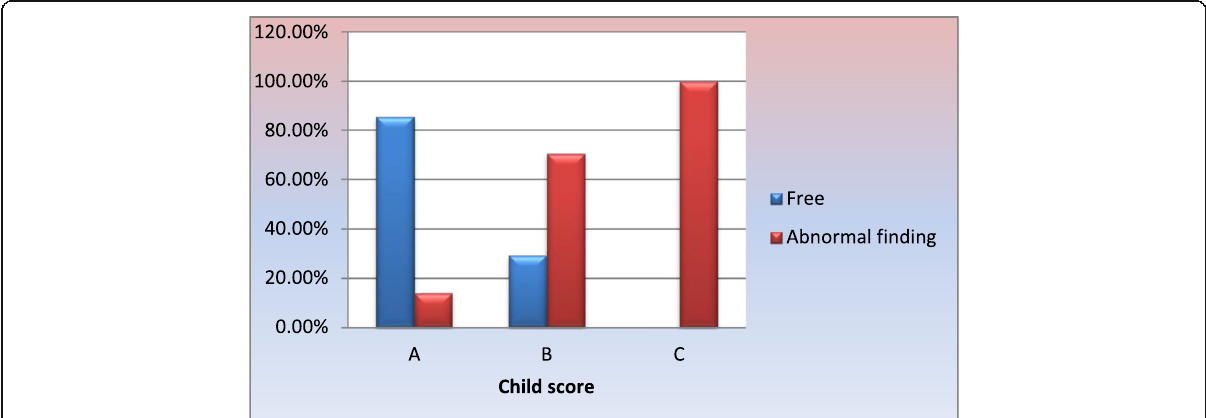
Fig. 2 Percentage of Child score in small-bowel findings